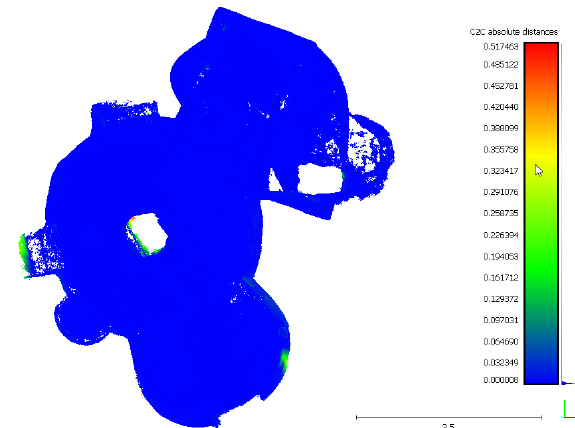
Figure 15. Absolute distances (in meters) between terrestrial laser scanner and close-range photogrammetric point cloud for the “Sybil hypogeum”.